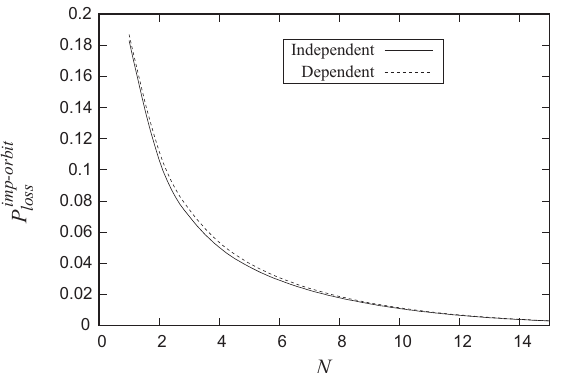
− orbit on the number N loss